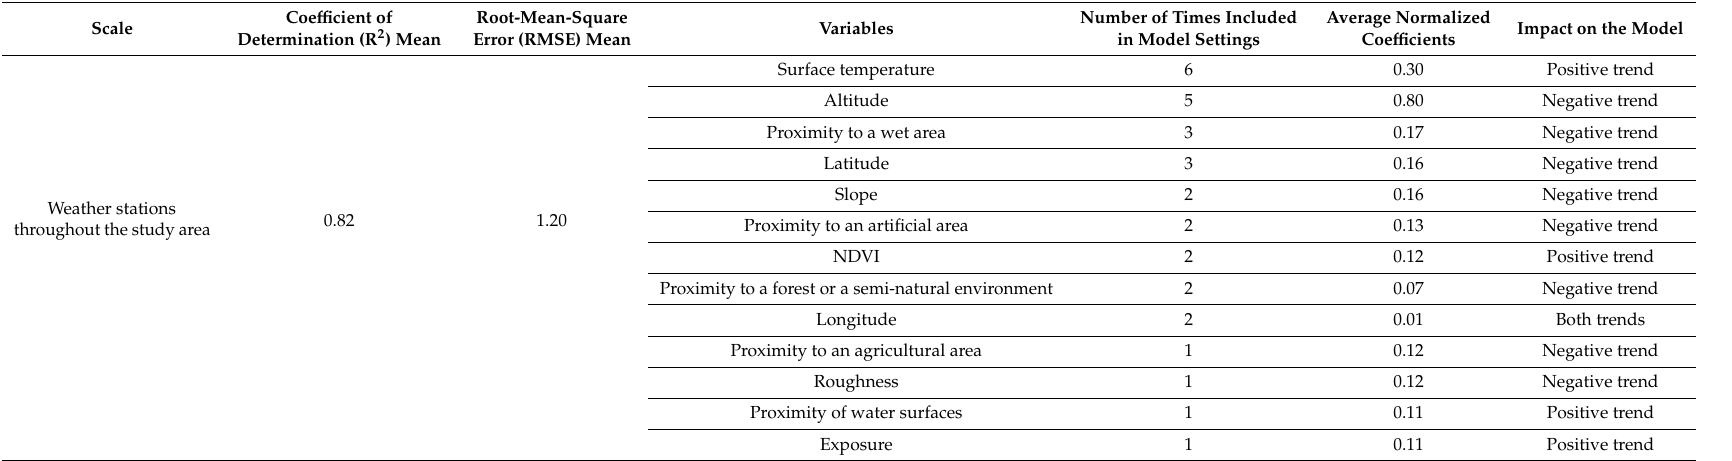
Table 5. Set of explanatory variables retained by multiple linear regressions for the year